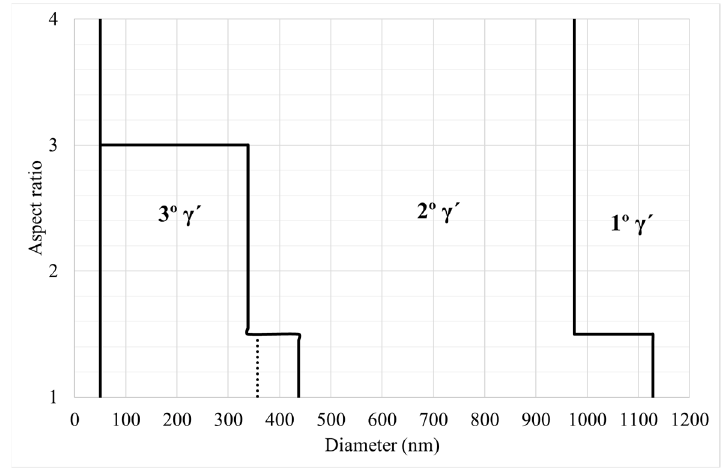
Figure 5. Segmentation parameters for γ′ precipitates in cans, the small change for cubes is reflected as dot points.